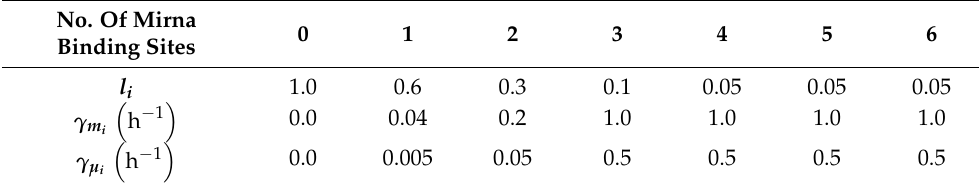
Table 2. Kinetic parameters for the EMT circuit ODE model (post-transcriptional